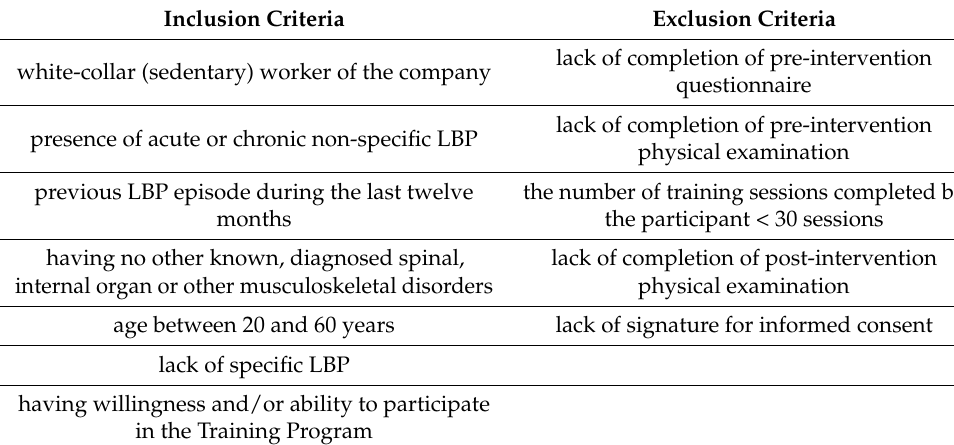
Table 1. Inclusion and exclusion